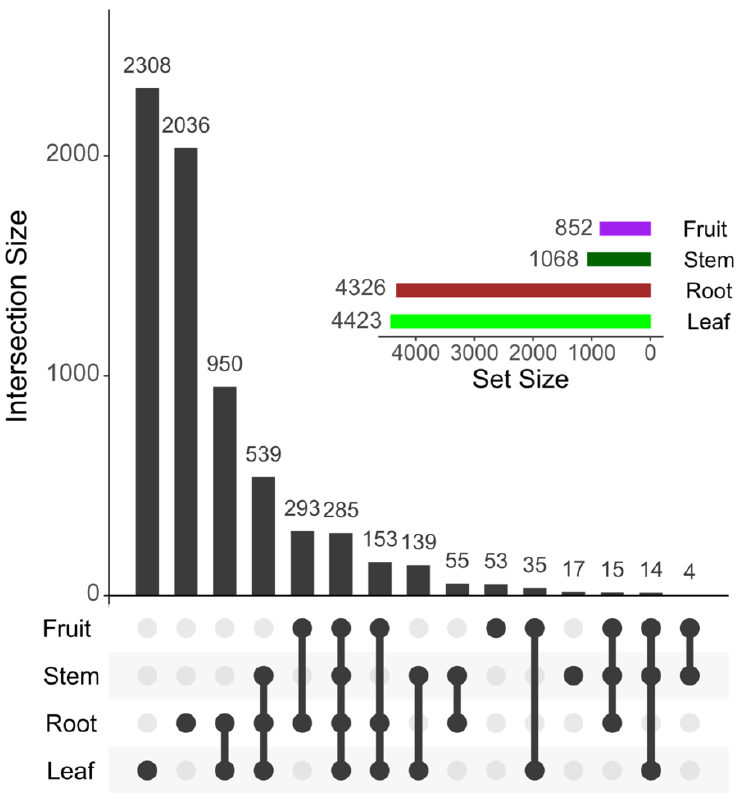
Figure 2. Overlapping patterns of the features detected among the eggplant anatomical sites. The 6896 aligned features (at the MS1 level) were visualized using UpSet plotting (UpSetR version 1.4.0; https://rdocumentation.org/packages/UpSetR/versions/1.4.0, accessed on 10 August 2022), wherein the bar height (intersection size) denotes the proportion of the features assigned to each unique (singular black dot or circle) or shared anatomical site (multiple linked black dots or circles). The Set Size (bars colored) denotes the total number of features detected by the anatomical site.